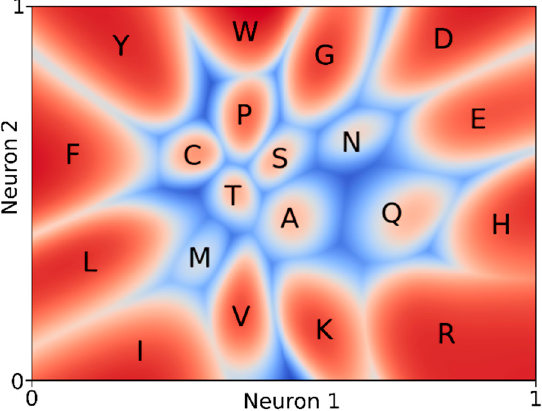
Figure 3. Autoencoder results for the MSA column reduction with fixed order of the twenty amino acid types over the column. These results are beyond the scope of this article but will be discussed extensively on the associated website: https://swift.cmbi.umcn.nl/gv/EV/index.html, accessed on 1 July 2022. Neuron 1 and neuron 2 are the two elements of the 2-dimensional bottleneck vector of the autoencoder.